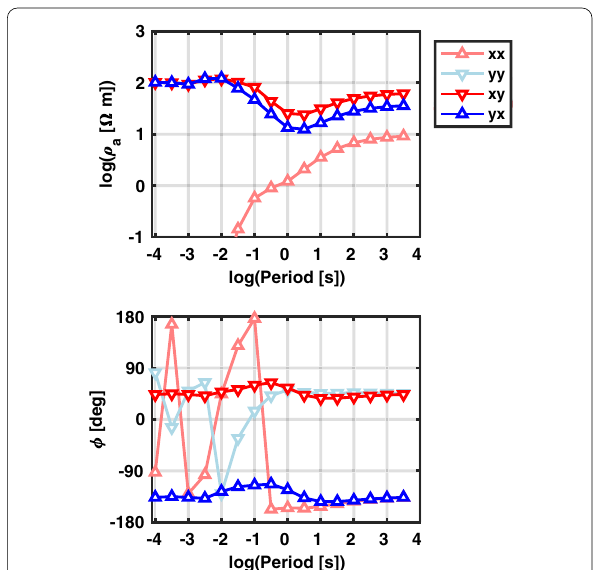
Fig. 2 Synthesized MT impedance elements at station syn‑0403